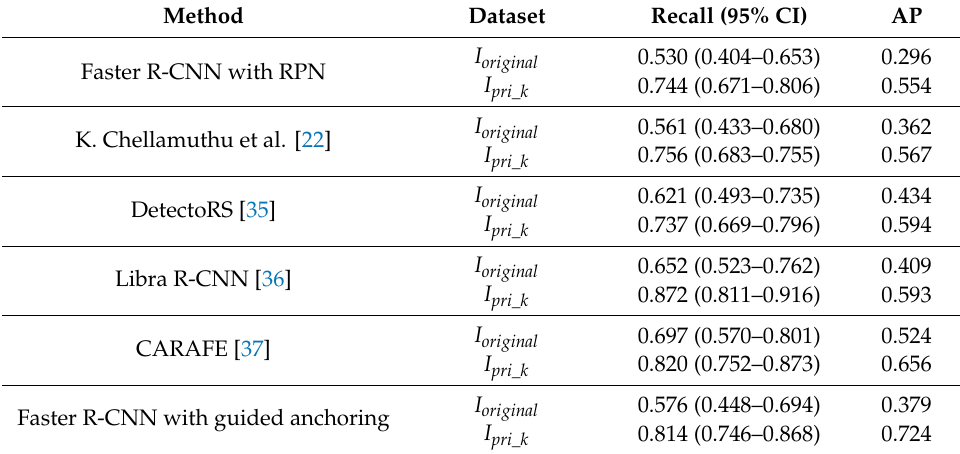
Table 4. The comparison results of Faster R-CNN with RPN, K. Chellamuthu et al., DetectoRS, Libra R-CNN, CARAFE, and Faster R-CNN with guided anchoring trained on original dataset and dataset with prior knowledge, respectively. CI = confidence